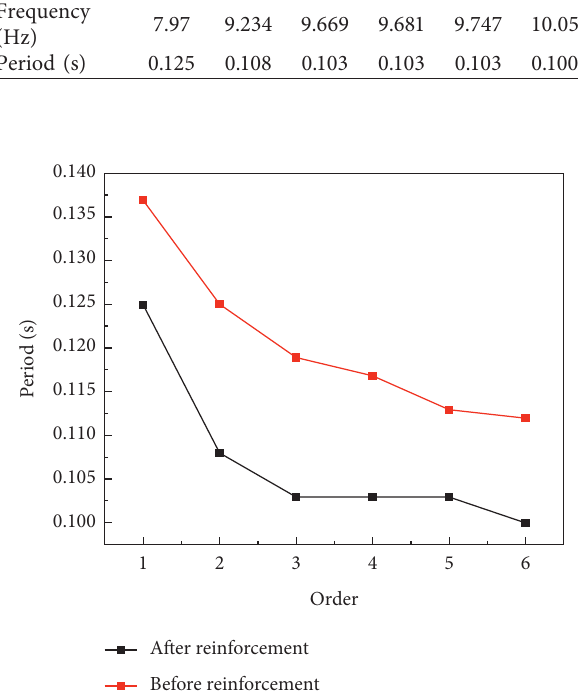
Figure 16: Comparison of natural vibration periods before and after